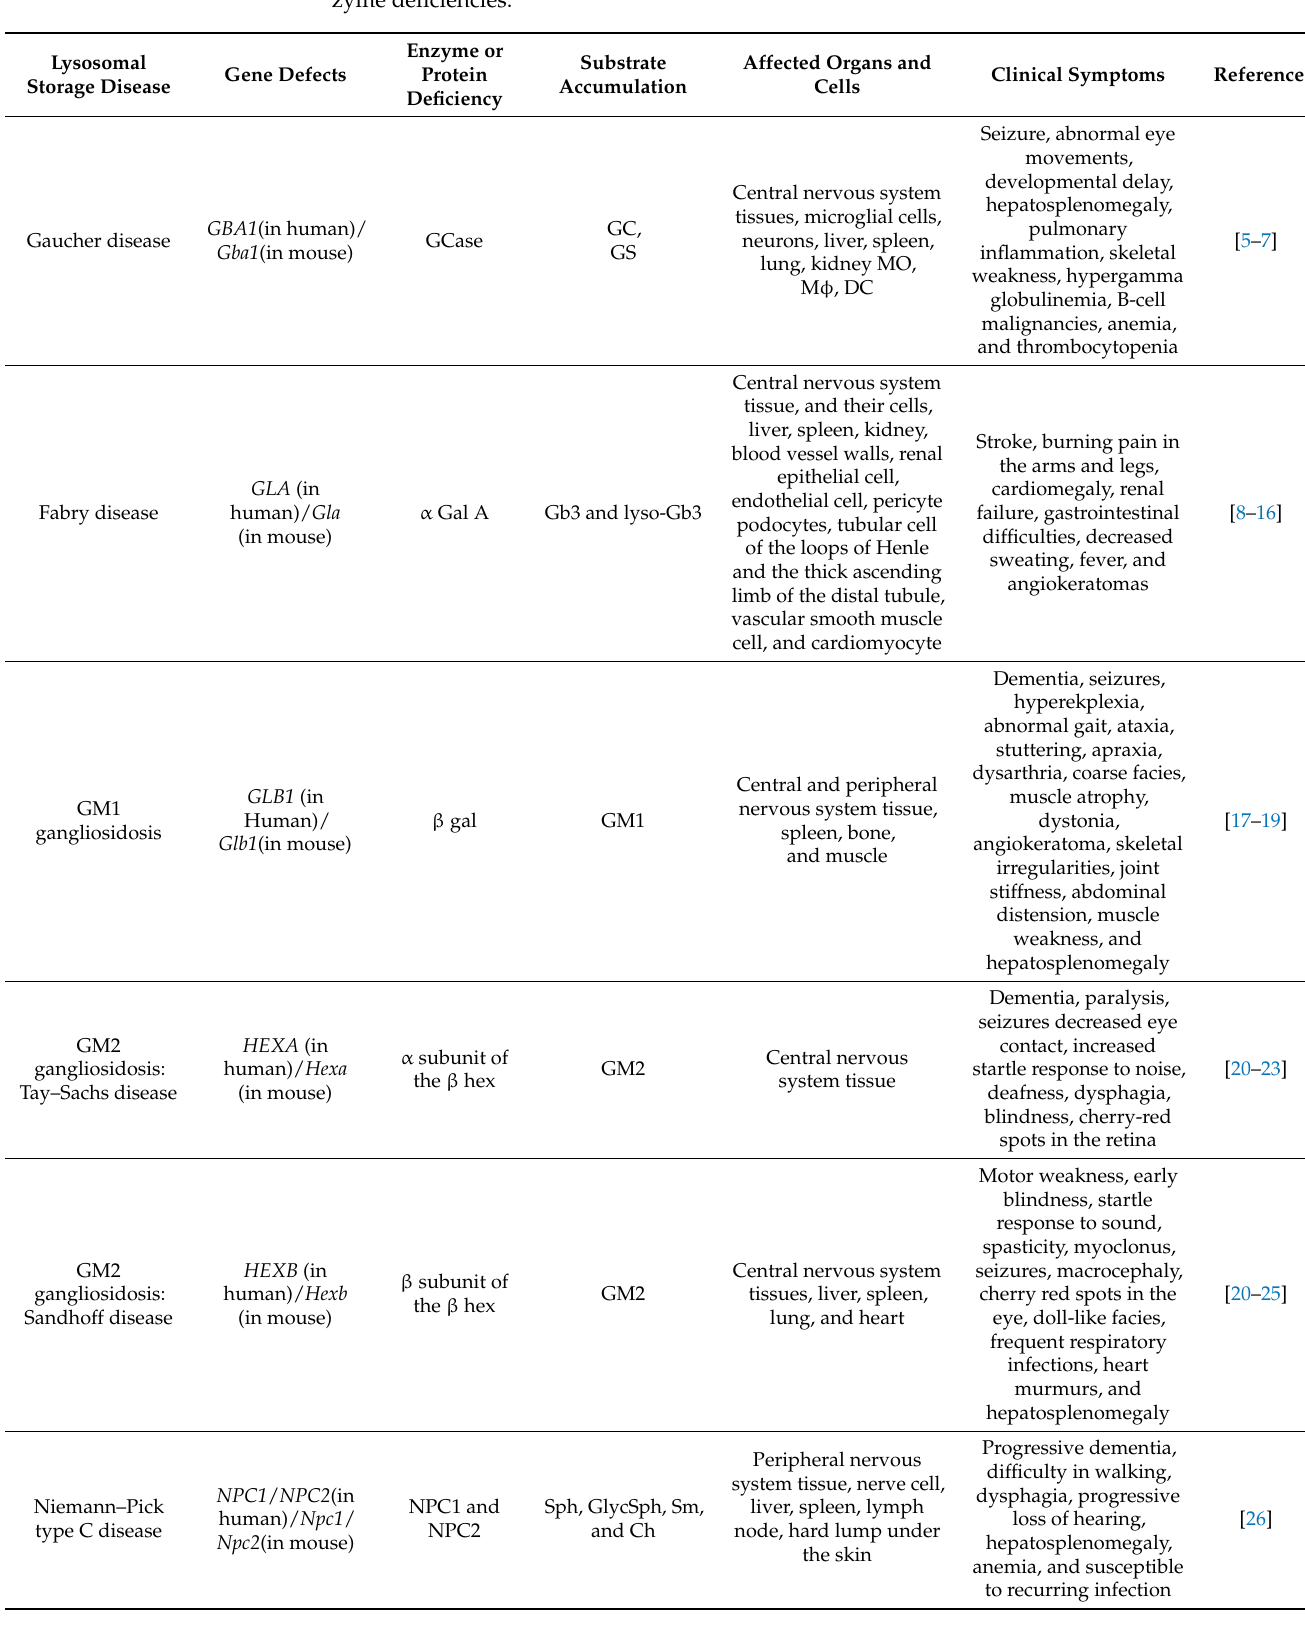
Table 1. The clinical symptoms of lysosomal storage diseases caused by genetic defects and en- zyme